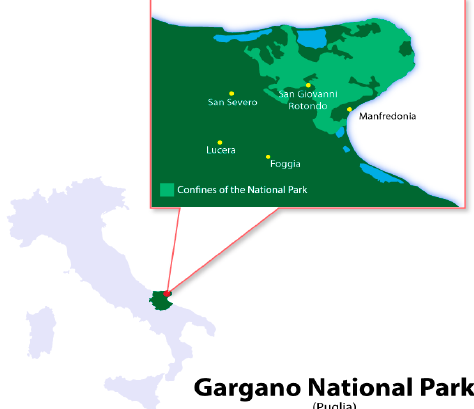
Figure 1. The Gargano National Park.